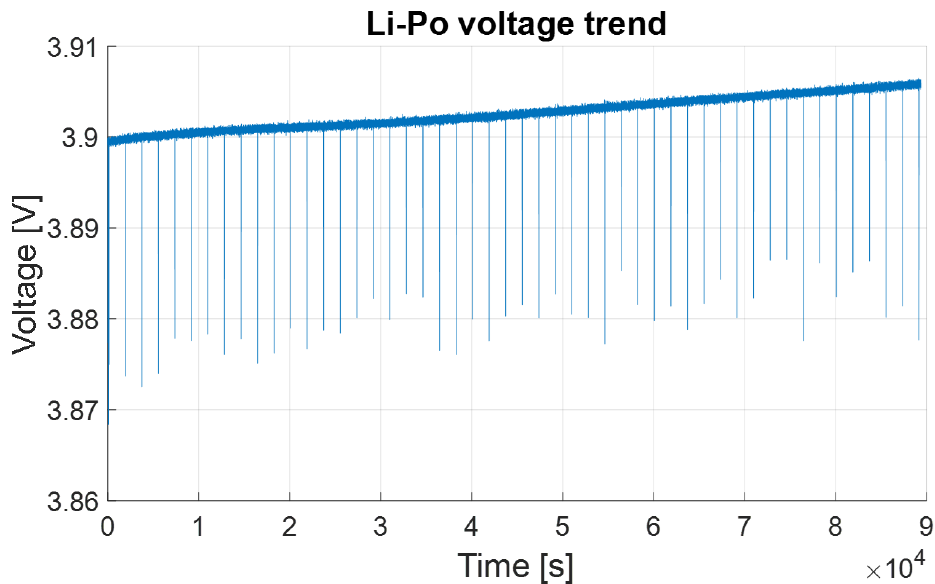
Figure 12. Li-Po voltage trend with radio transmissions every 30 min, MPPT set to 80% and ∆ T = 5